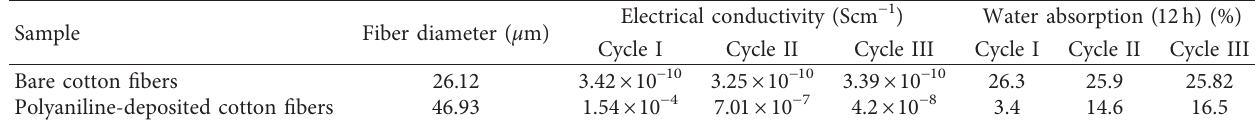
Table 2: Water absorption, swelling behavior (in terms of diameter), and electrical properties of bare cotton fibers and polyaniline- deposited cotton fibers.